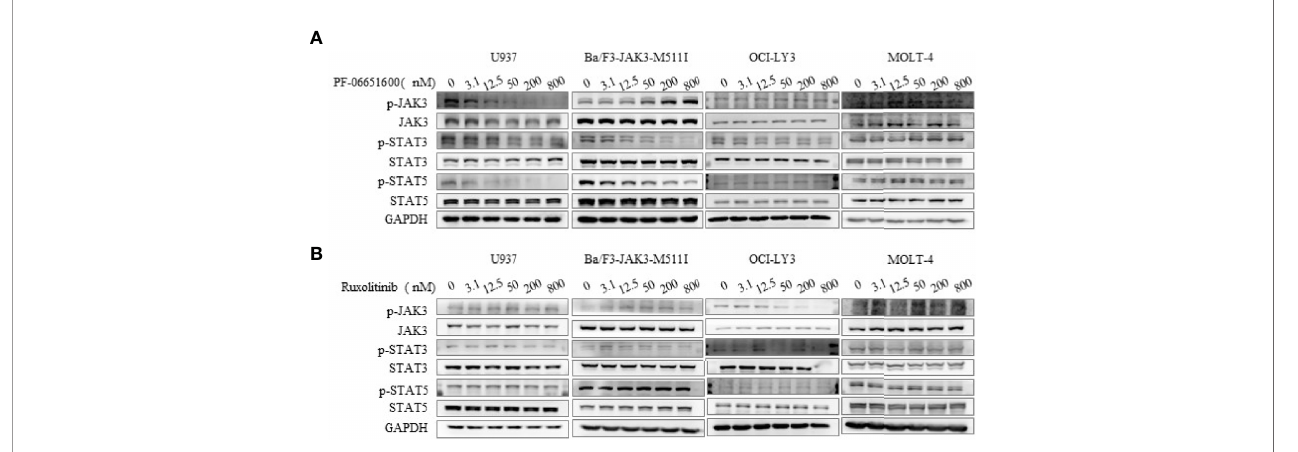
FIGURE 3 | Selective JAK3 inhibitor inhibited the activation of JAK3 and downstream signaling molecules in U937 cells. The effects of PF-06651600 (A) or ruxolitinib (B) on JAK3-STAT3/5 signal pathway in U937, Ba/F3-JAK3-M511I, OCI-LY3, and MOLT-4 cancer cell